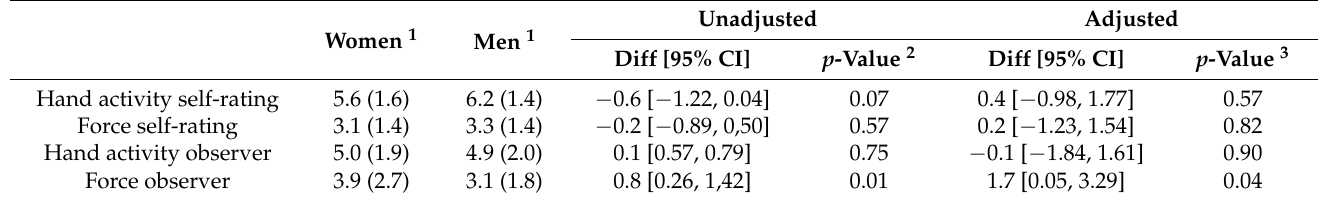
Table 5. Ratings as the means and the unadjusted (paired samples t -test) and adjusted (linear mixed model) differences for the covariates grip strength, forearm length and finger